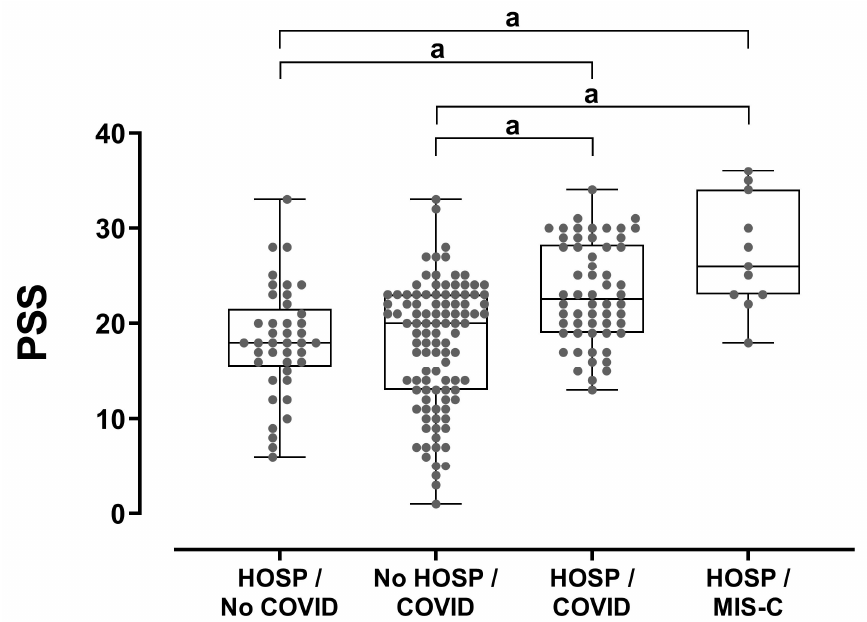
Figure 3. Parental stress levels in relation to hospitalization and COVID-19 status. Between-group comparisons were performed using Kruskal–Wallis and Dunn’s post hoc tests. HOSP: hospitalization. a: represents the comparison groups.